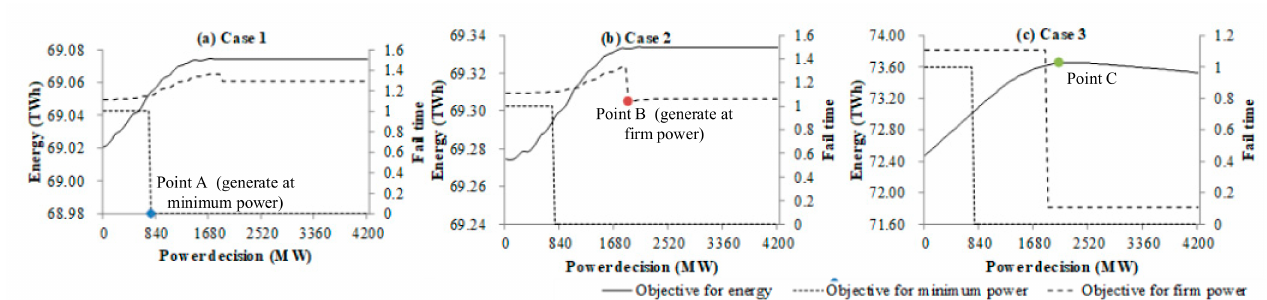
Figure 2. Decision decided by different